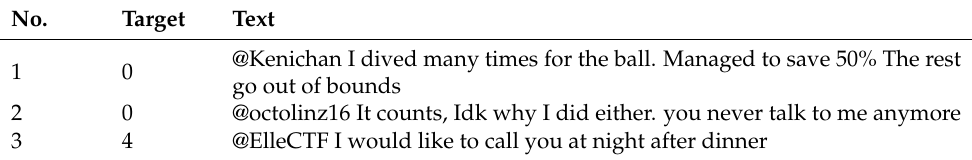
Table 2. Tweet sample from the